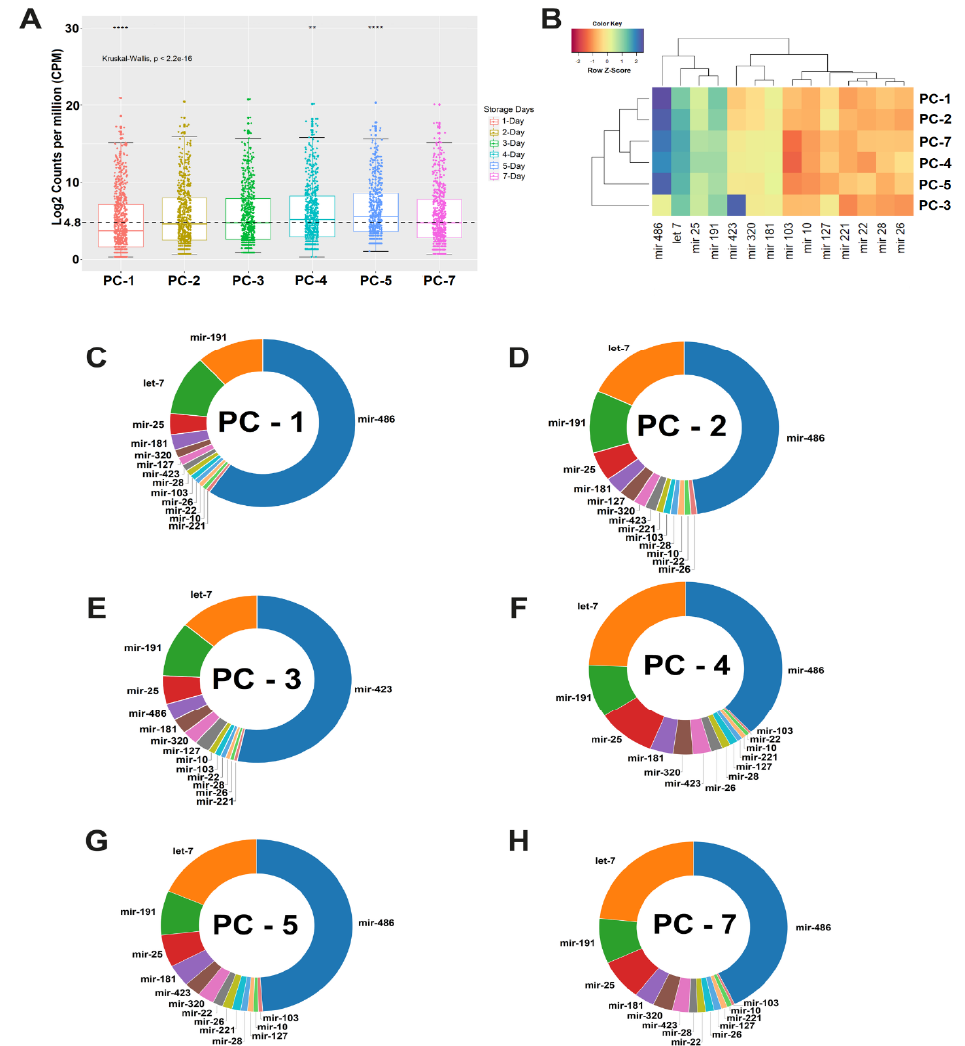
Figure 1. ( A ) Average levels of normalized expression in Log 2 counting per million reads (CPM) of miRNA in platelet concentrates (PCs). The average expression was 4.8 CPM. Boxplot is designed from the 75th to the 25th percentile. The vertical lines above and below the box define the maximum and minimum values and the dots indicate outliers, the horizontal line inside the box represents the median value. Kruskal–Wallis test ( p -value < 0.001) was applied to compare the means between the six groups (** p < 0.01, **** p < 0.0001); ( B ) The heatmap shows an expression profile defined by the most abundant miRNA families in all PCs. Z-score was the metric applied to infer the best clustering between miRNA families. Gradients with a red tendency represent families of miRNAs with a lower Z-score and gradients with a blue tendency with a higher Z-score; ( C – H ) Donut chart shows the ranking of miRNA family positions on all PCs. PC, platelet